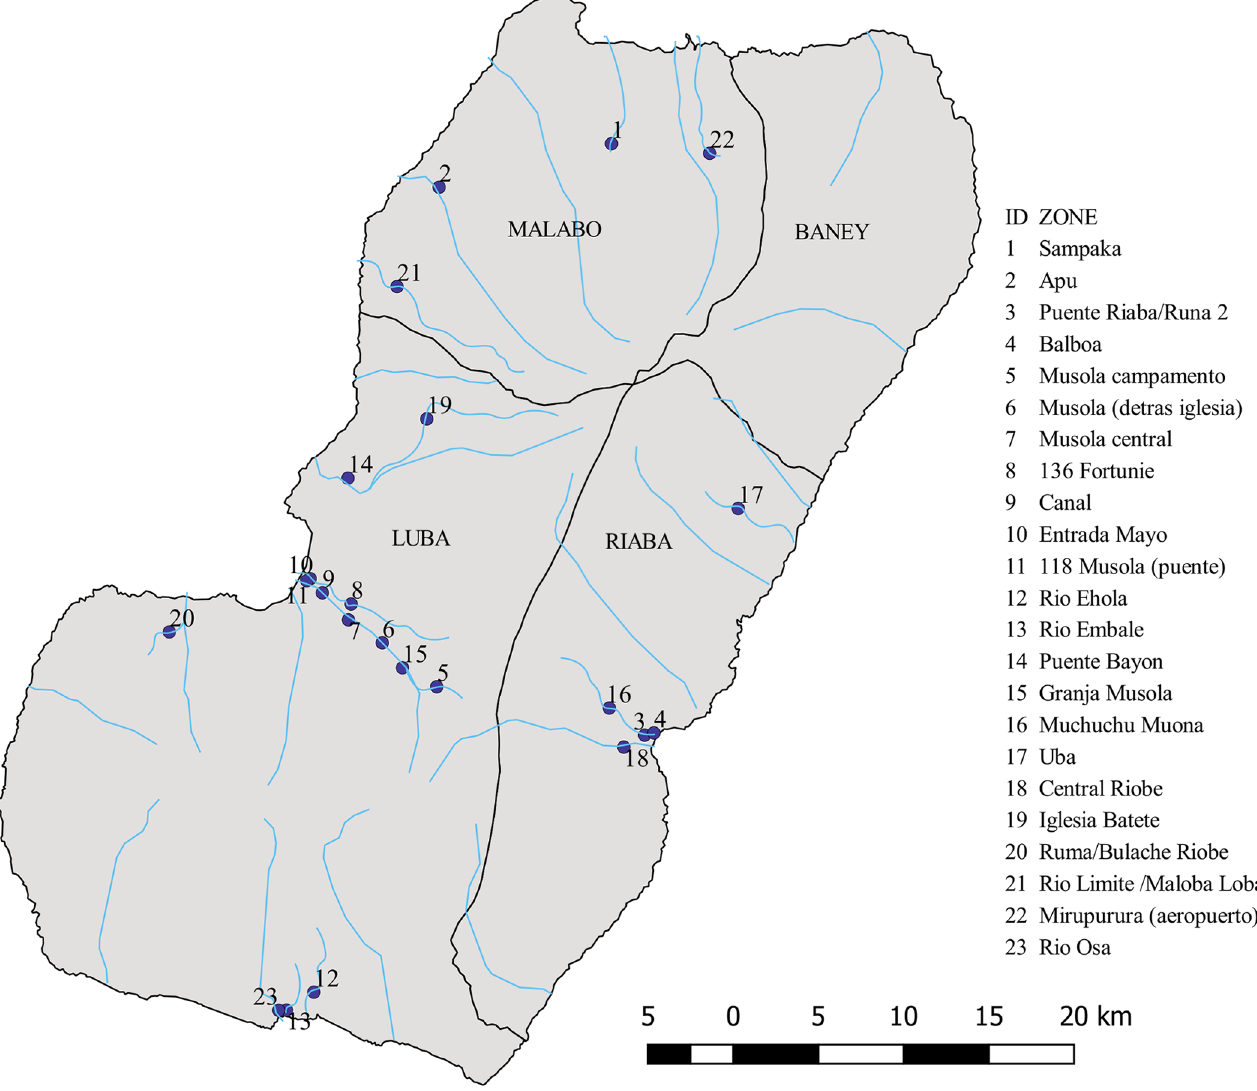
Fig 3. Entomological survey of potential breeding sites, Bioko Island, September 2016 to February